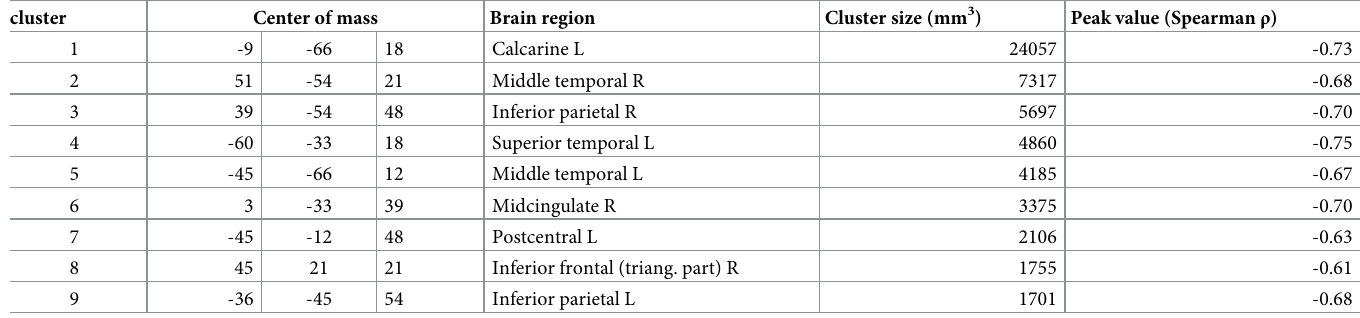
Table 3. Cluster report for correlations between matrix metalloproteinase (MMP) concentrations and regional cerebral blood flow (CBF). Cluster centers of mass are given in MNI coordinates and the brain regions are identified based on the nearest labelled grey matter region in the automated anatomical labelling (AAL) atlas. cluster Center of